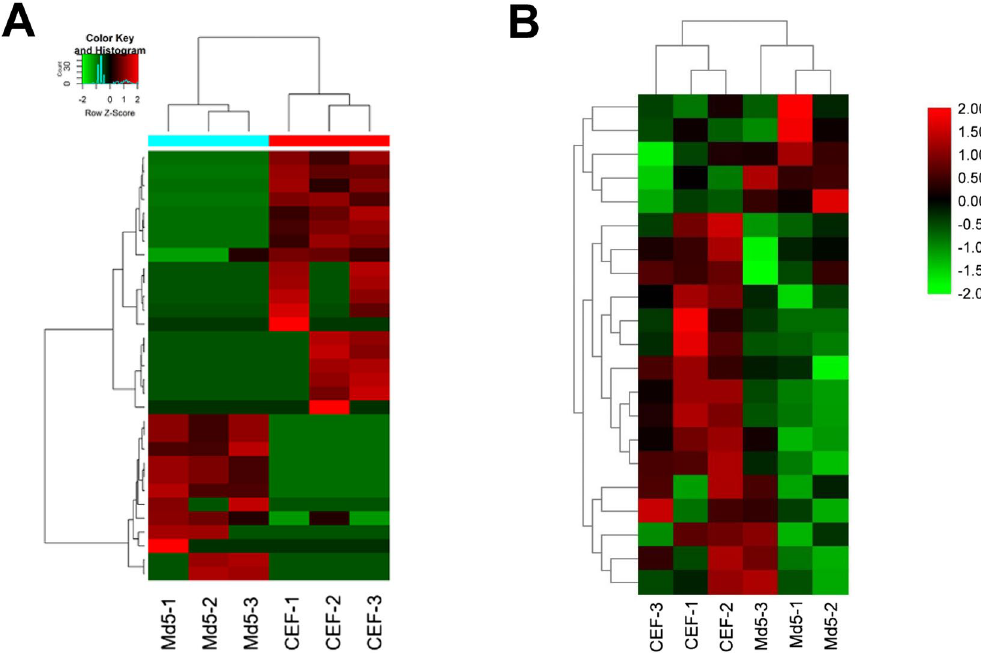
Figure 4. m 6 A modification clustering analysis. ( A ) Cluster analysis of m 6 A methylation at the transcriptome level. ( B ) Cluster analysis of m 6 A m6A modified lncRNA genes in the infected and control groups. The color represents the size of the log-fold enrichment (FE) value: the closer the color is to red, the larger the logFE value. Md5-1, Md5-2, Md5-3 represent the Md5-infected CEF group with three independent replicates. ( Made by Tbtools, v1.082, http:// www. tbtoo ls. org).